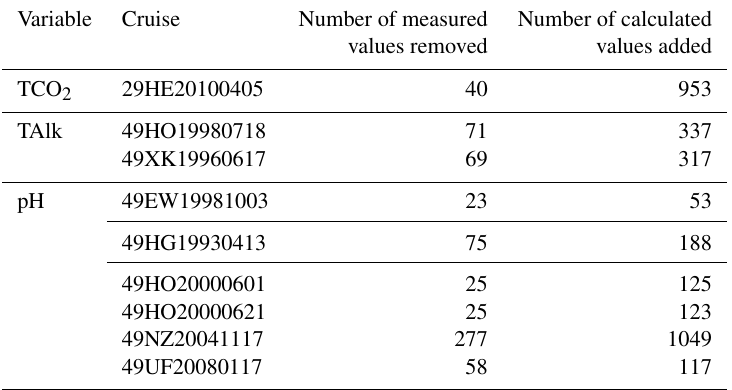
Table 9. Cruises where measured carbon variables have been fully replaced with calculated ones in the GLODAPv2 product files. One of these cruises is from the Atlantic (29HE20100405), while the remainder are Pacific